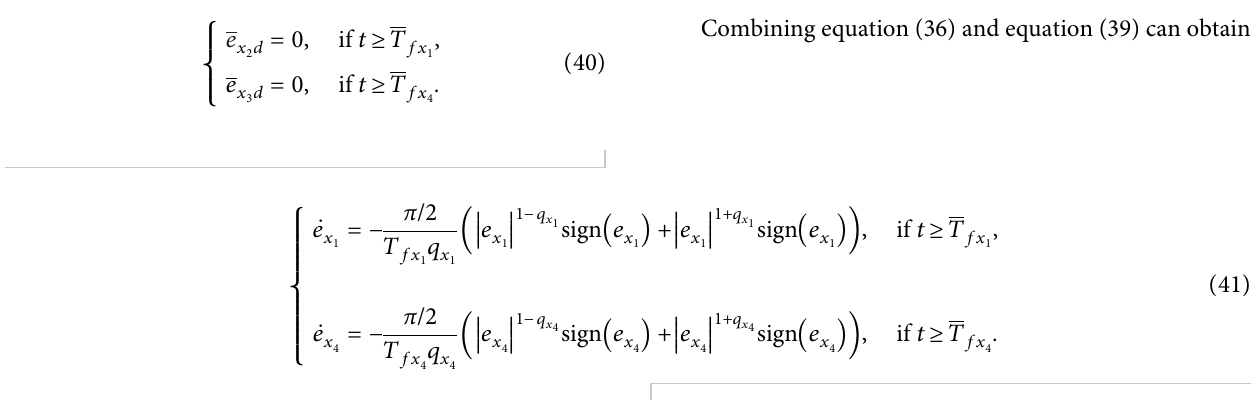
Figure 23: Te system synchronization error. (a) e